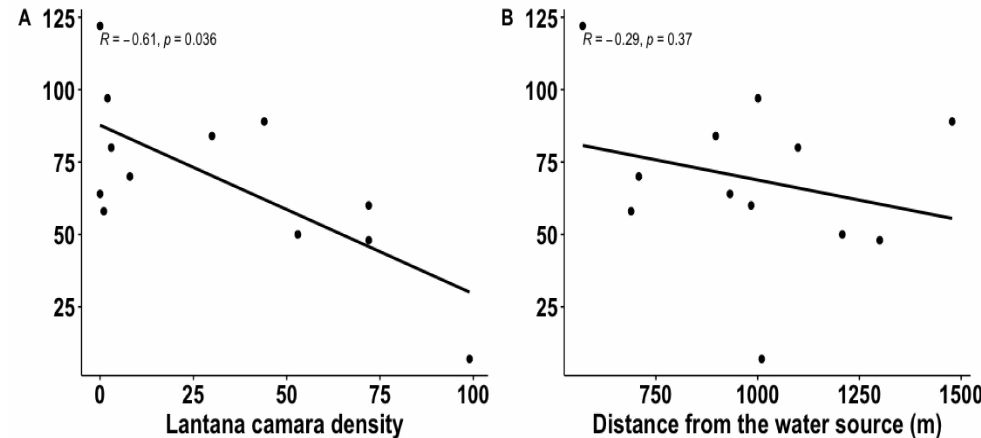
Figure 3. Scatterplots of the distribution of the overall species richness (track counts per species and per treatment type) by the density of Lantana camara around the treatments ( A ) and the distance of treatments from the water source ( B ) inside the Groenkloof Nature Reserve, South Africa.